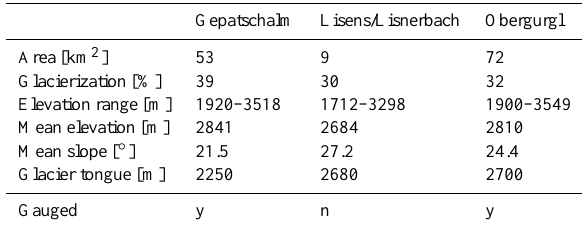
Table 1. Topographic features of the study